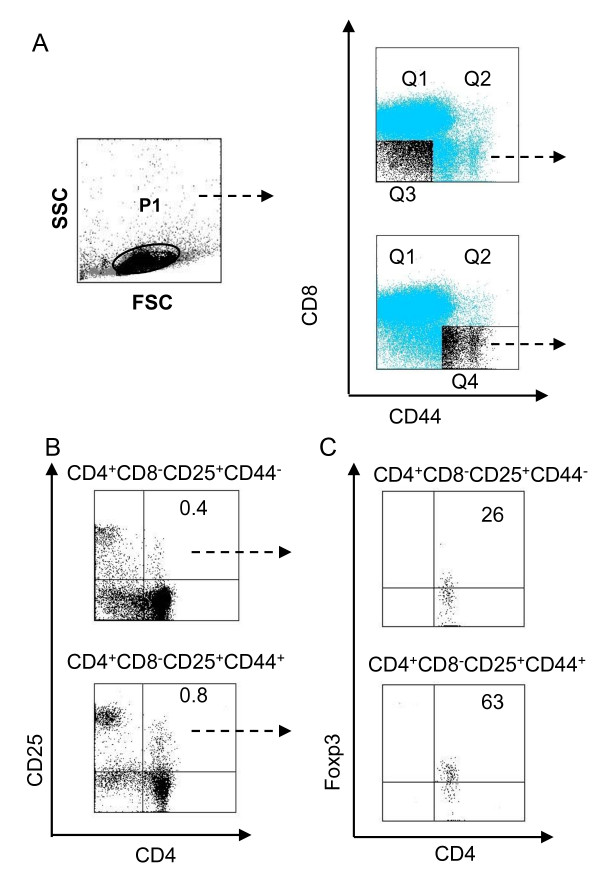
Detection of CD4+ CD8- CD25+ CD44+ and CD4 + CD8- CD25+ CD44- Treg cells in the thymus. (A) Cell gating strategy and staining patterns. Thymocytes were obtained from naïve C57BL/6 mice and stained with specific antibodies against CD4 (Cy7-PE), CD8 (FITC), CD44 (PE), and CD25 (APC-Alexa Fluor755). Cells in P1 were gated as live thymocytes. (B) Based on CD44 and CD8 expression, CD4+CD8-CD25+CD44+ and CD4+CD8-CD25+CD44- cells were defined. (C) Foxp3 expression in CD4+CD8-CD25+CD44+ and CD4+CD8-CD25+CD44- cells. The data are shown as the percentage of total, live thymocytes (population P1) in each cell subset, and are presented as mean ± S.D. from four independent experiments.